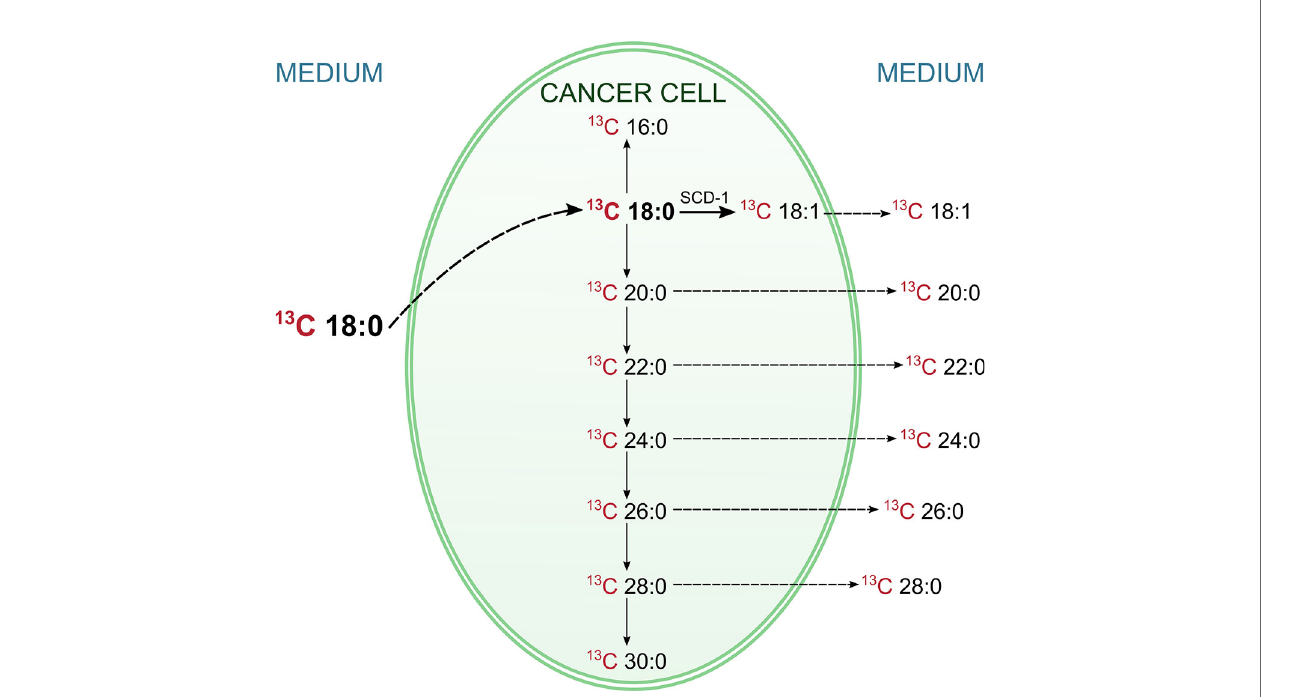
FIGURE 1 | Pathways of conversions of labelled 13 C stearic acid in HT-29 CRC cell. The labelled 13 C stearic acid was added into HT-29 CRC cell culture, and during the incubation its level in medium was decreasing, whereas inside the cells was increasing. This indicate, that 13 C stearate has been absorbed by cancer cells. At the same time the labeled products of the metabolism of this FA (including VLCFA and oleic acid) appeared in the cells. Moreover, they appeared also in the medium, and their levels in medium was increasing. This experiment proved that CRC cells can synthesize oleic acid and VLCFA from stearic acid and release them outside the